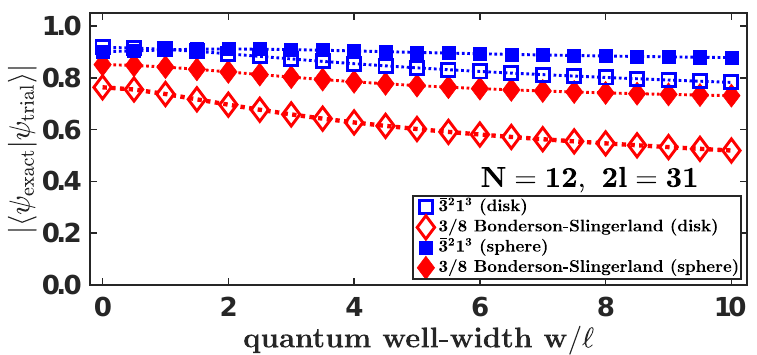
Figure 8: (color online) The overlap of the ¯3 2 1 3 state (blue squares) with the ex- act second Landau level Coulomb ground state evaluated in the spherical geometry using the disk (open symbols) and spherical (filled symbols) pseudopotentials for various widths w for N = 12 electrons at 2 l = 28. This system aliases with the 3 / 8 Bonderson-Slingerland state; therefore, for comparison, we have also shown its overlaps (red diamonds) with the exact second Landau level Coulomb ground